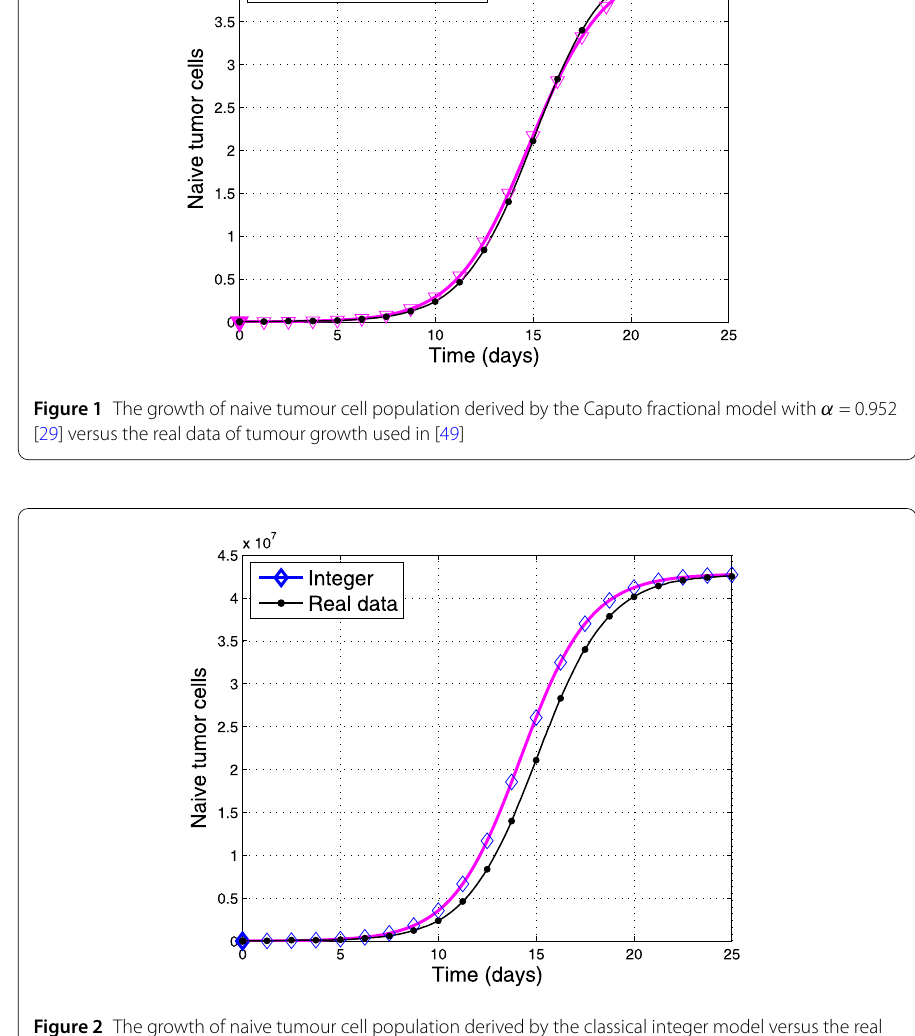
of fractional operators passed several periods, and various attempts have been presented (see for example [20, 25, 46–48] and the references therein). In our opinion, so far, there has been no consensus achieved on the main criteria that classify the fractional opera- tors. The experimental facts registered and reported in CERN easily have minimised the solid mathematical constructions such as string theory and super-symmetry in favour of standard models based on much simpler concepts and more physical concepts as gauge invariance. Constructing nice complicated fractional operators may not give the best out- put always when we create models involving them. Besides, it seems that there is not a unique fractional operator which can be used to describe all types of processes having dif- ferent types of memory effects. In our opinion, the classification in the classes of fractional operators is more reasonable [25] from both experimental and mathematical